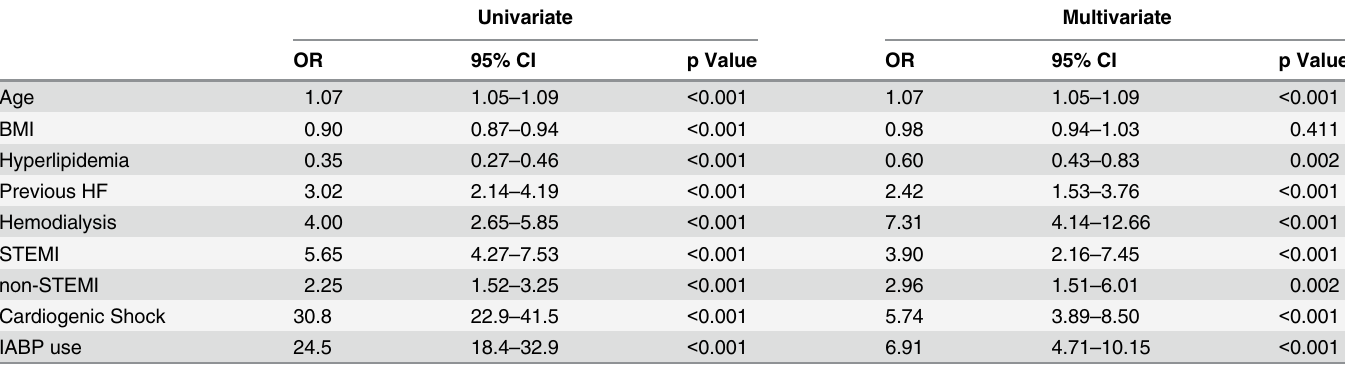
Table 5. Multivariate Logistic Regression Analysis on In-hospital Mortality in the Total Cohort.